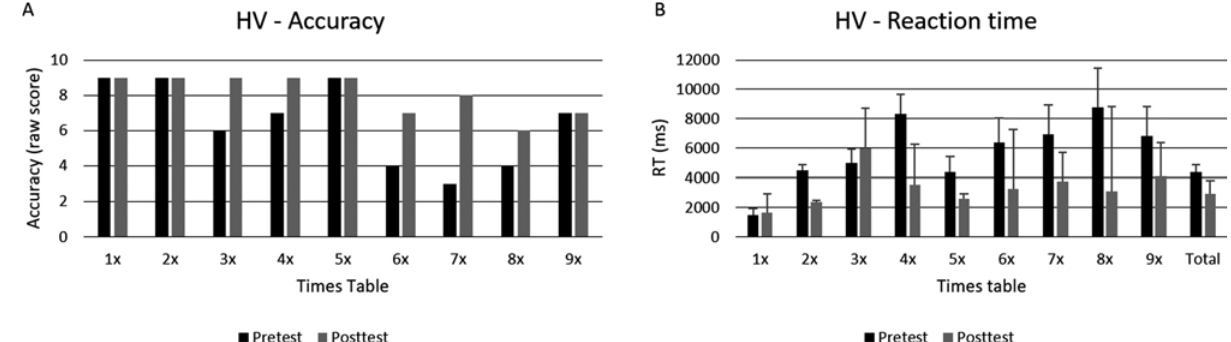
figure 1. HV’s raw score and median reaction time (ms) in the MTT.